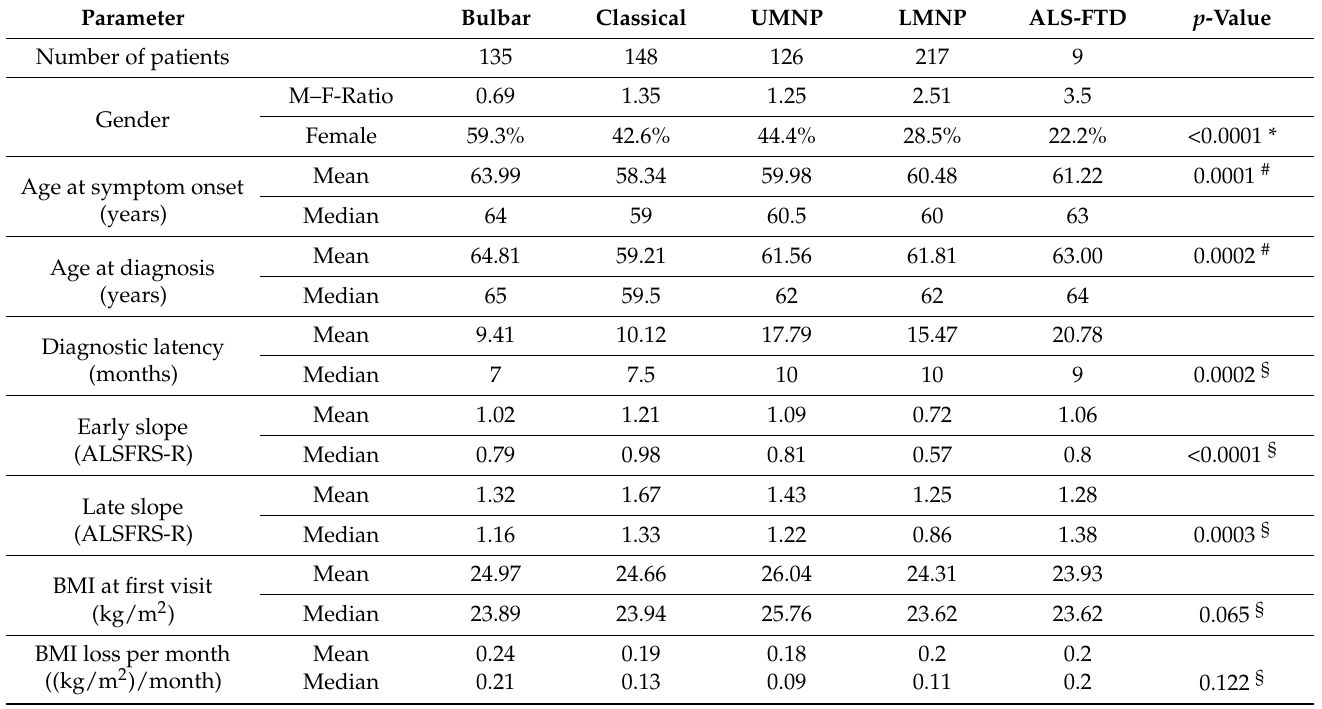
Table 2. Clinical characteristics of different ALS